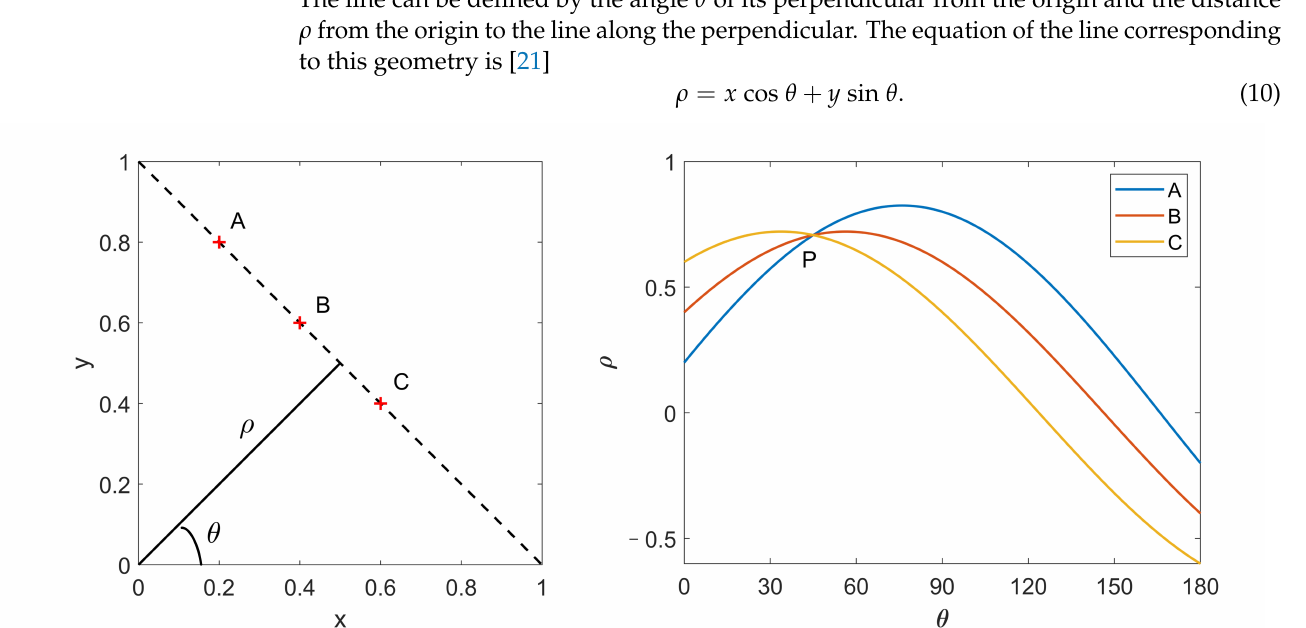
Figure 1. (Color online) Geometric plot of the Hough Transform in the x − y data space and in the ρ − θ parameter space. A, B and C indicated by the red plus markers are three points in the data space; the three curves in the parameter space are the transformed results of the three points; the three curves have a common intersection